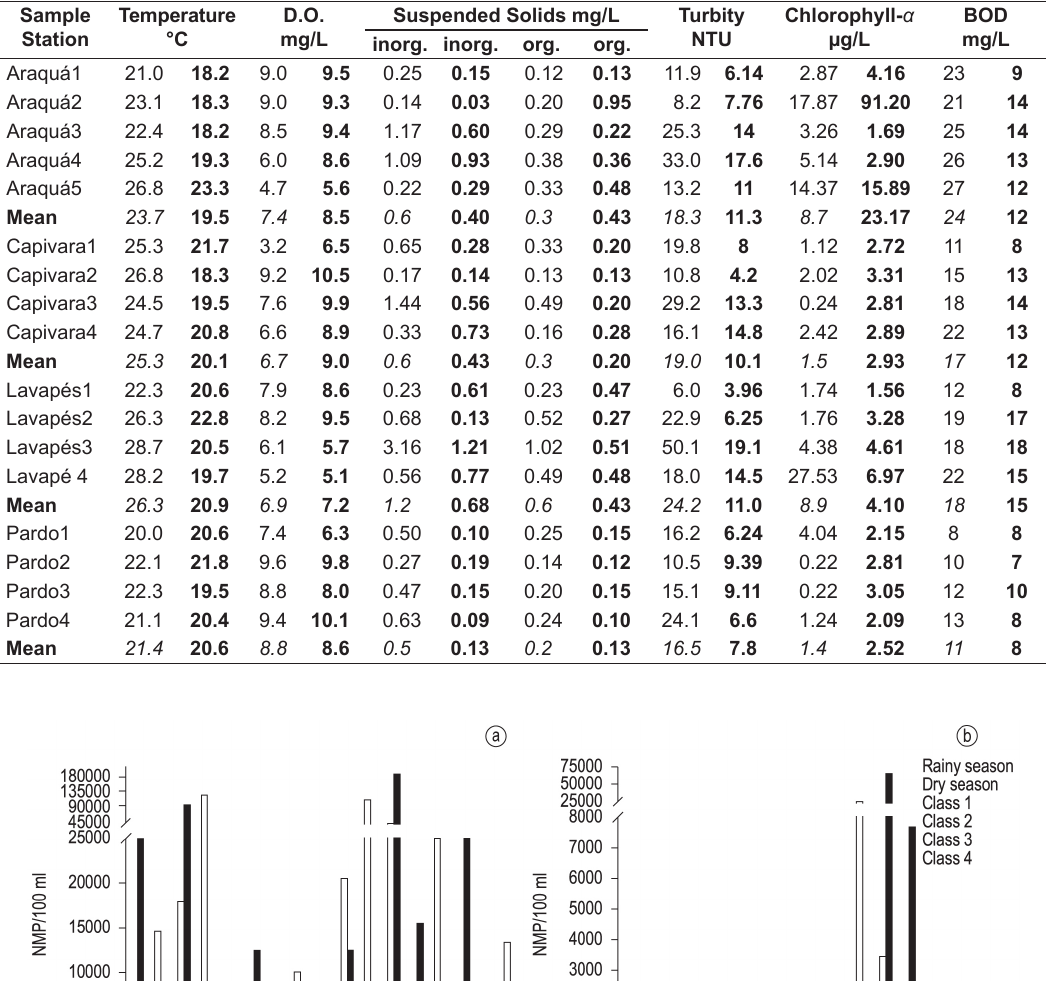
Table 3. Water temperature, dissolved oxygen (D.O.), suspended solids (organic and inorganic), turbidity, Chlorophyll - a and biochemical oxygen demand (BOD) measured in Araquá, Capivara, Lavapés and Pardo Rivers during the rainy and dry (in bold) periods of 2007.